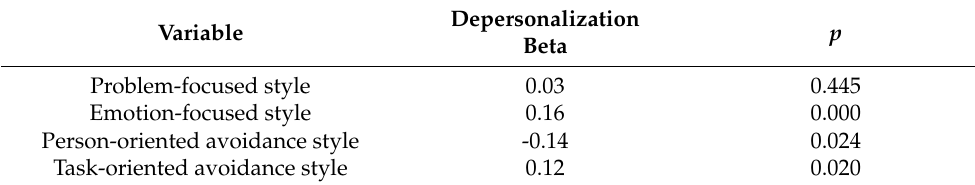
Table 6. Multiple regression model, the three coping styles as predictors to the explained variable of